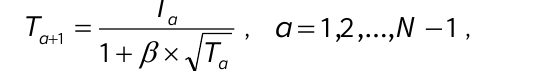
Figure 3. The proposed SA